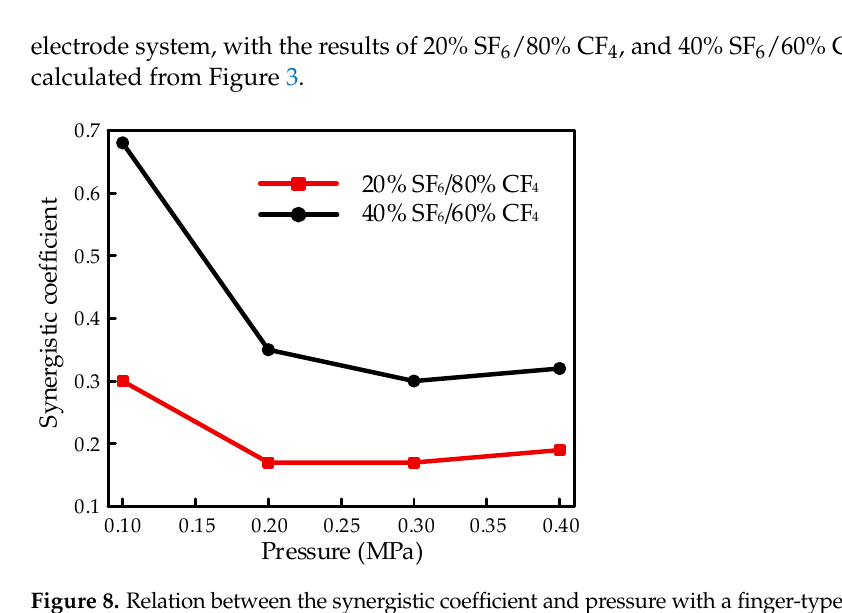
Figure 8. Relation between the synergistic coefficient and pressure with a finger-type electrode sys- tem.